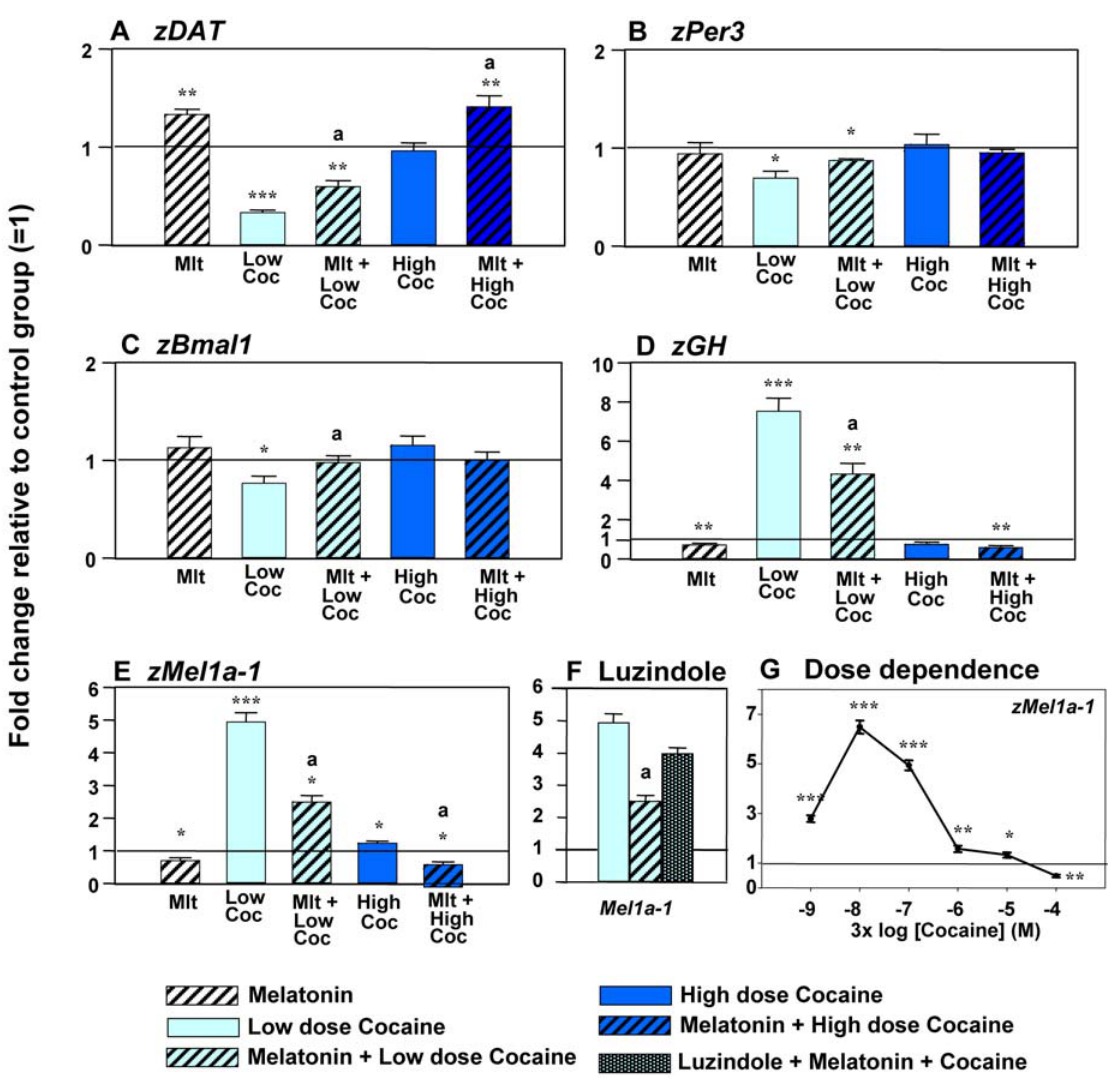
Figure 2. Prenatal daytime cocaine exposure dose-dependently alters expression of genes involved in neurotransmission (A) circadian system (B, C) growth (D) and melatonin signaling (E), and these effects are counteracted by melatonin. (A–E) Melatonin (100 nM for 45 min), Low (0.3 m M) or High (30 m M) cocaine doses (15 min), with or without melatonin pre-treatment (100 nM, 30 min). ( F ) Melatonin receptor antagonist Luzindole attenuates the counteracting effects of melatonin on cocaine-induced changes in the expression of all six melatonin receptor genes; only one ( zMel1a-1 ) receptor shown. Treatments: luzindole 50 m M for 20 min prior to melatonin; melatonin 100 nM for 20 min prior to cocaine; cocaine 0.3 m M for 15 min. ( G ) Dose-dependent effects of cocaine (20 min) on melatonin receptor expression. Y axis: fold change relative to control (=1). N=3–4 samples/treatment group, 25 embryos/sample. Mean 6 SEM, t -test (vs. control), * p , 0.05, ** p , 0.01, *** p , 0.001; One way ANOVA (between treatments), a: p , 0.05, vs. cocaine-only group. Mlt-melatonin;